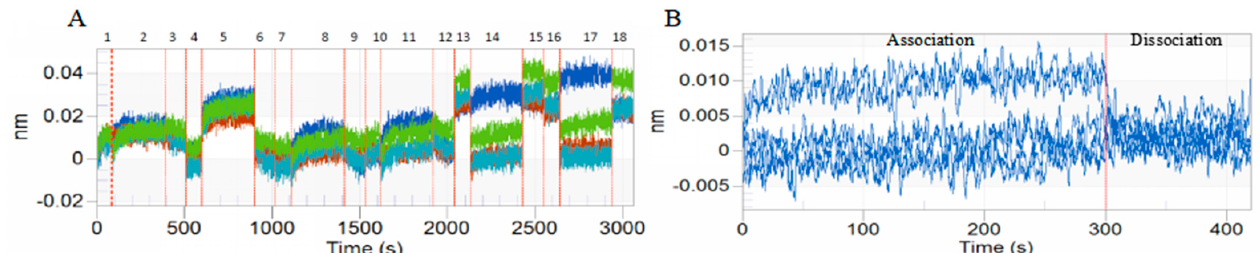
Figure 1. Kinetic curves and align analysis of the interaction between DA and BmTMEM214 in BLI tests. ( A ) Interaction curve between BmTMEM214 and DA. – SSA sensor of solidified BmTMEM214 with serial dose of DA. – SSA sensor of solidified BmTMEM214 reference buffer. – SSA sensor of non-solidified protein and serial dose of DA. – SSA sensor of non-solidified protein and reference buffer. ( B ) Align X diagram of association and disassociation in the interaction between DA and BmTMEM214.